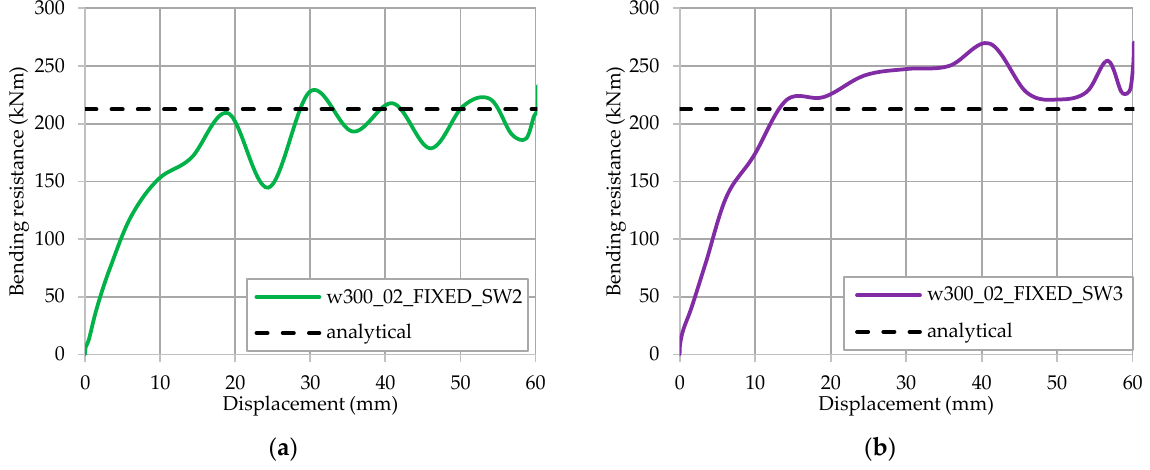
Figure 22. Bending resistance of the fixed beam for shear connectors spaced at 300 mm: ( a ) SW2; ( b ) SW3.